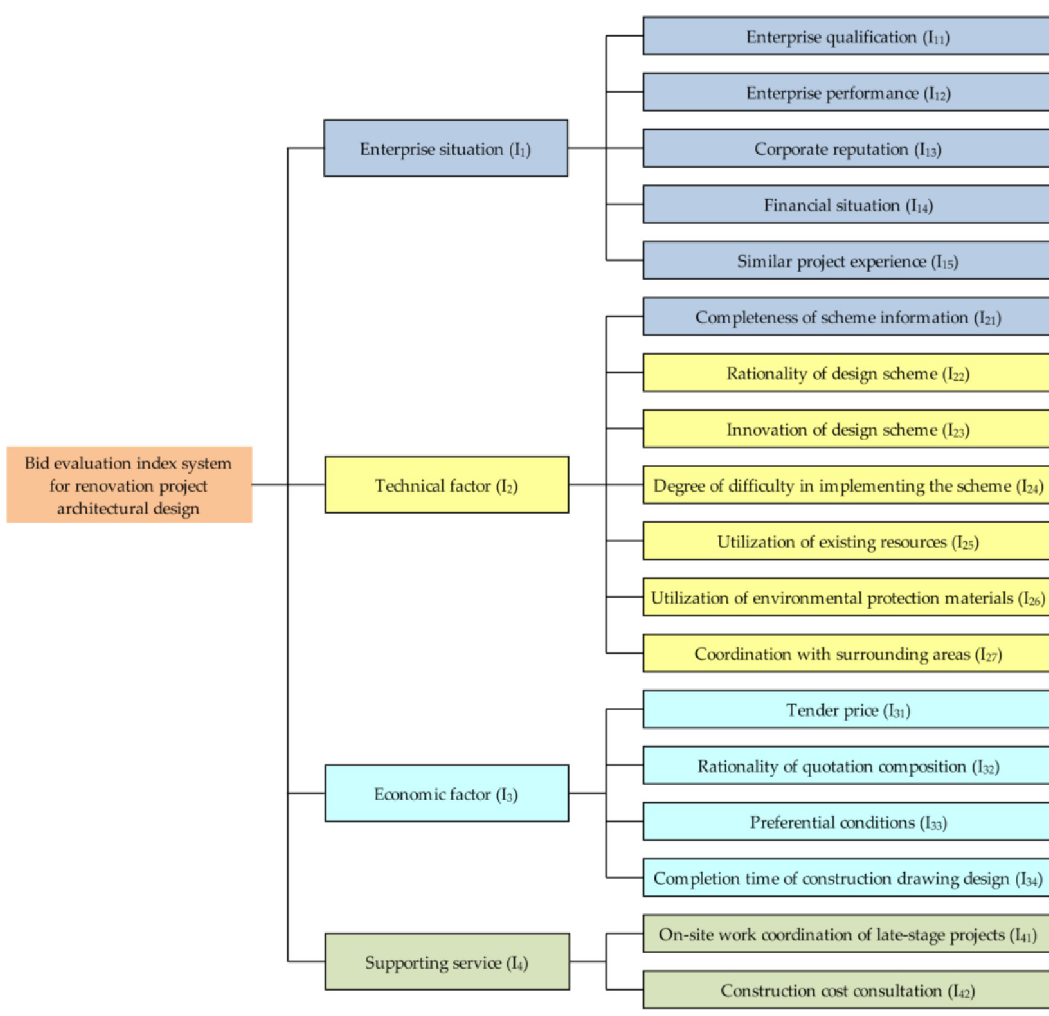
Fig 2. Bid evaluation index system for renovation project architectural